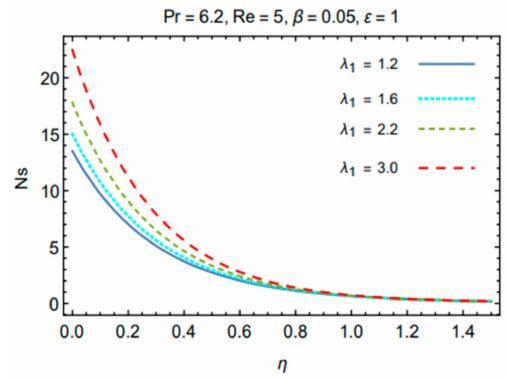
Figure 8. Variation in Ns against λ 1